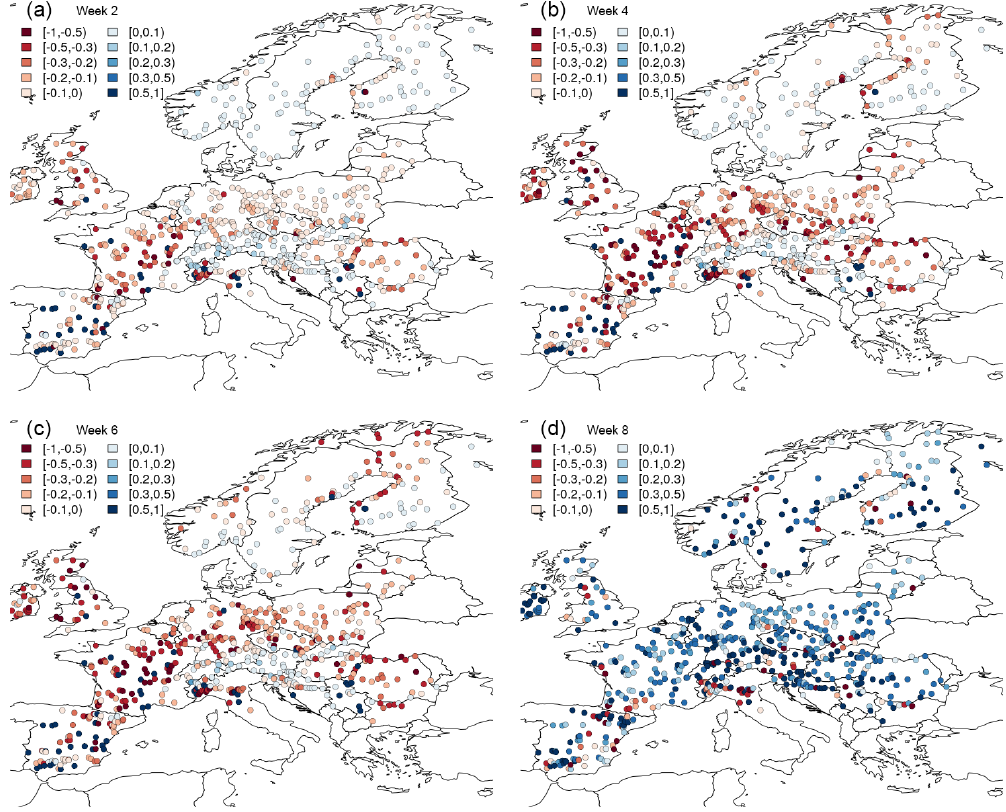
Figure 6. Mean relative error for each of the outlet points for the SEAM forecast over the outlet points for (a) week 2, (b) week 4 and (c) week 6. Red indicates where the forecast is too wet, and blue where it is too dry. (d) Shows the difference in absolute error between SEAM and SYS4, where blue (red) denotes points where SEAM has a smaller (larger) MAE than SYS4.